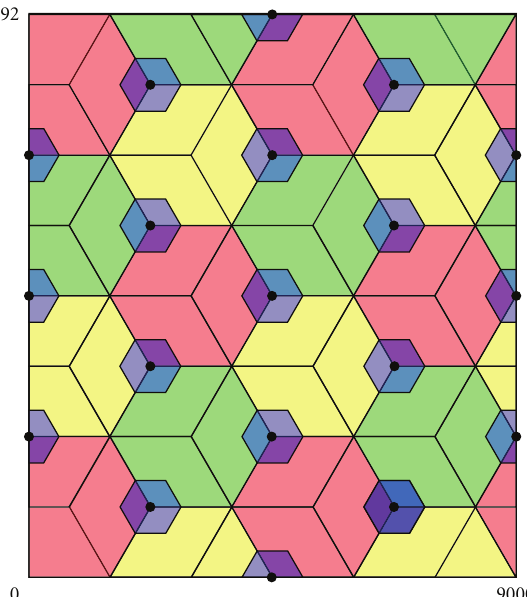
Figure 4: Cellular Layout with mixed fractional frequency reuse.